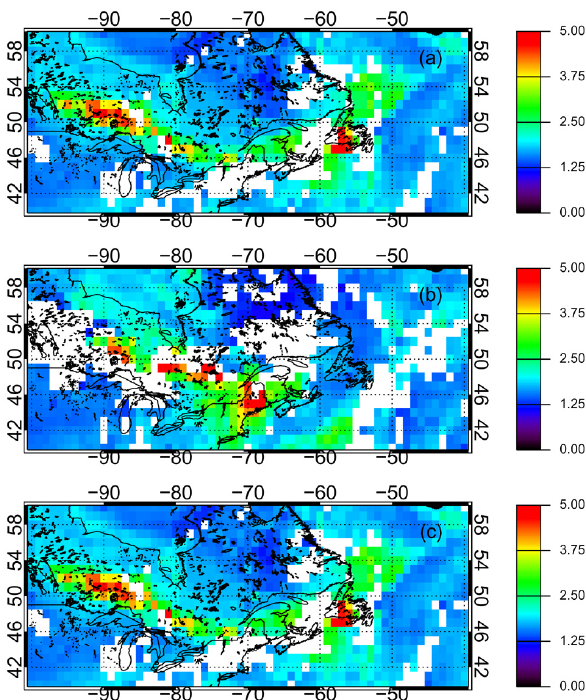
Fig. 9. The daytime mean total column CO (1 × 10 18 molcm − 2 ) on a 1 ◦ by 1 ◦ grid from the Infrared Atmospheric Sounding Interferometer (IASI) on the MetOp-A satellite for the dates (a) 18 July 2011, (b) 20 July 2011 and (c) 21 July 2011.